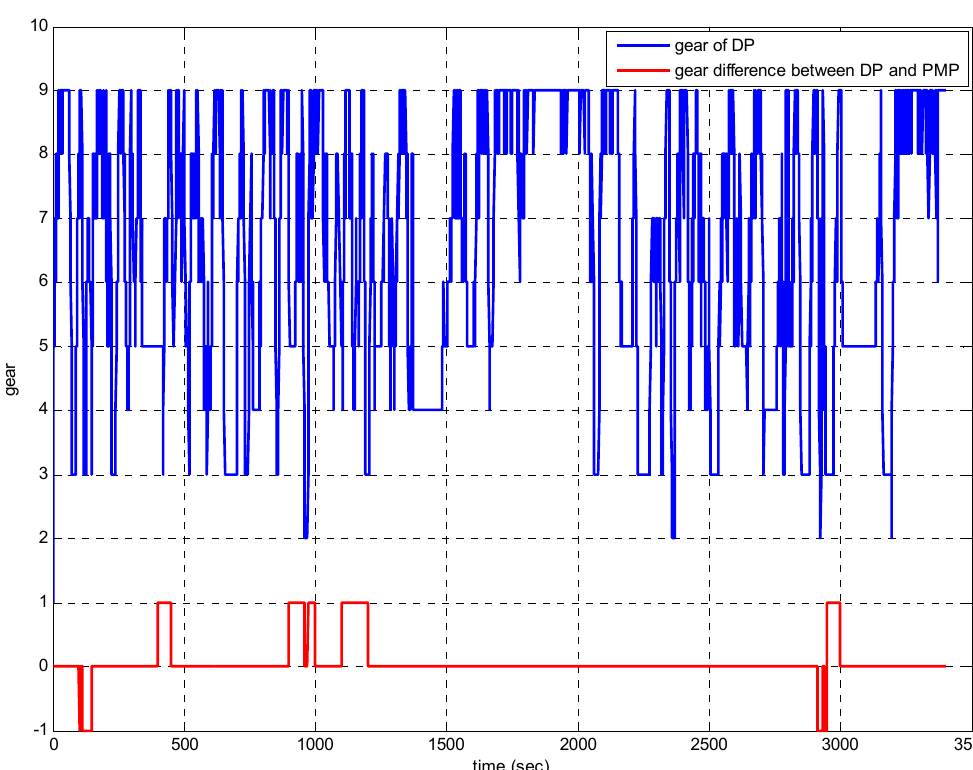
Figure 7. Gear shifting of DP and PMP.